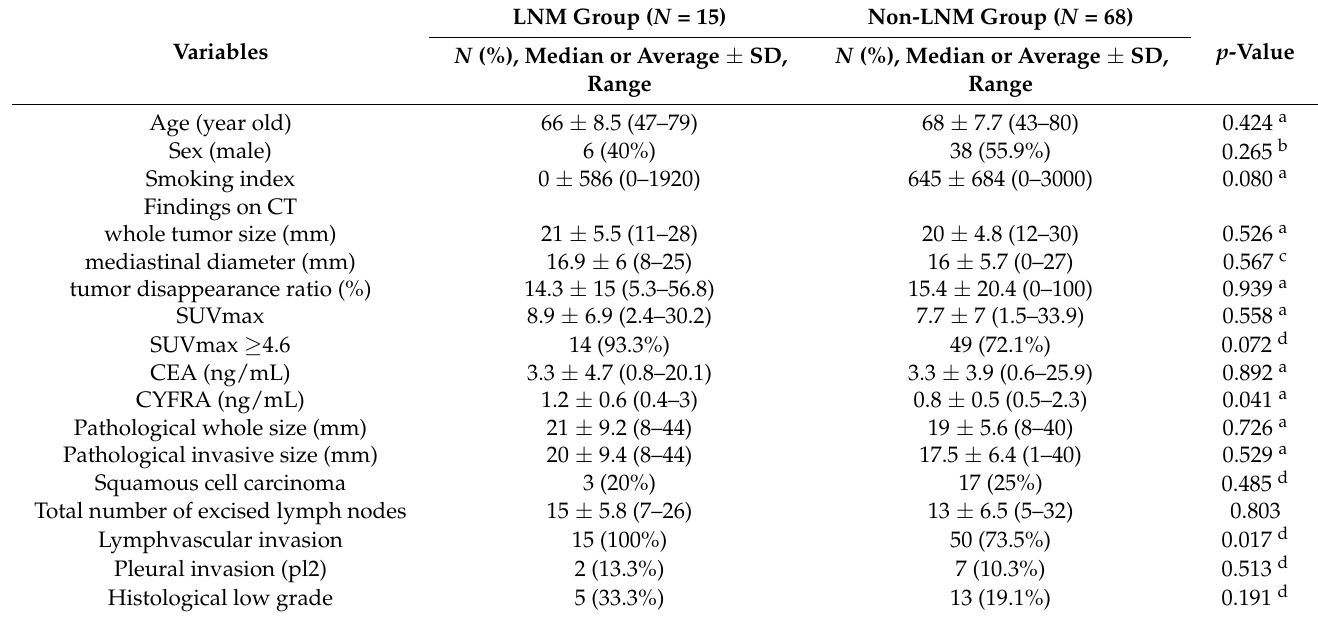
Table 3. Analysis of lymph node metastasis (LNM).